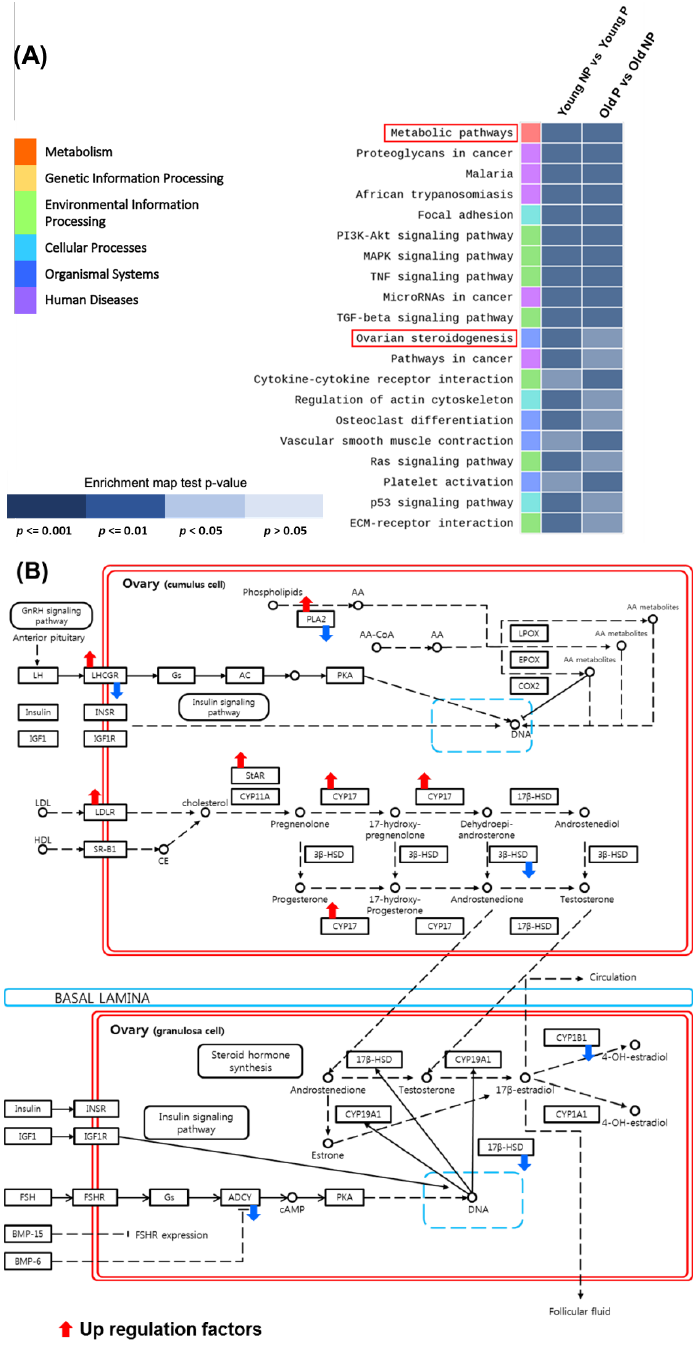
Figure 3. Functional annotation enrichment analysis of the whole-transcriptomes profile using Database for Annotation, Visualization and Integrated Discovery (DAVID). ( A ) Genes were categorized by gene set enrichment analysis according to age and pregnancy. Enrichment map test p -values, p < 0.001 to >0.05. Data are presented as means ± SEM of three replicates. Significant differences are indicated by asterisks (* p < 0.05). ( B ) Schematic of cumulus cell signaling pathway involving up- and downregulated genes, based on the ovarian steroidogenesis KEGG pathway map from the gene set enrichment analysis.